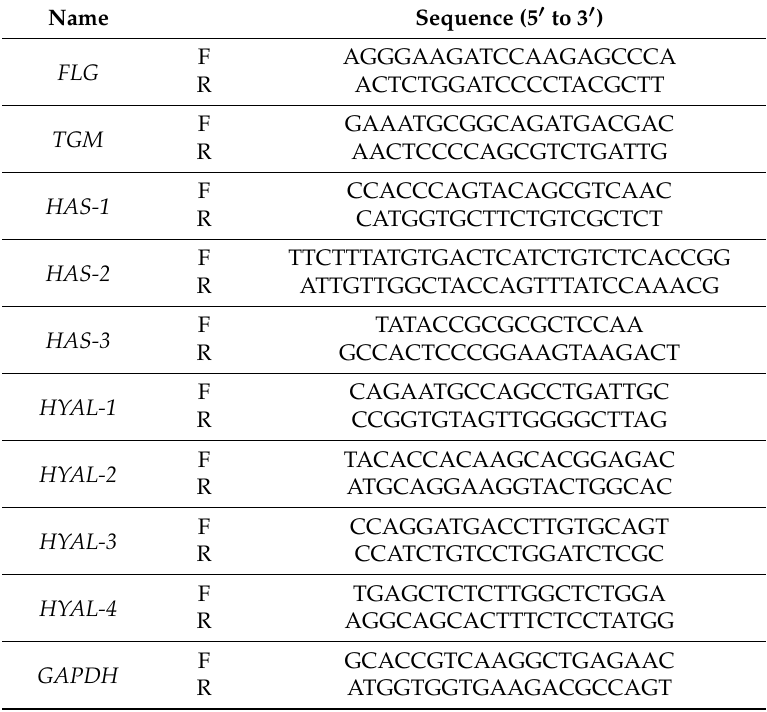
Table 1. Primers used for reverse transcriptase polymerase chain